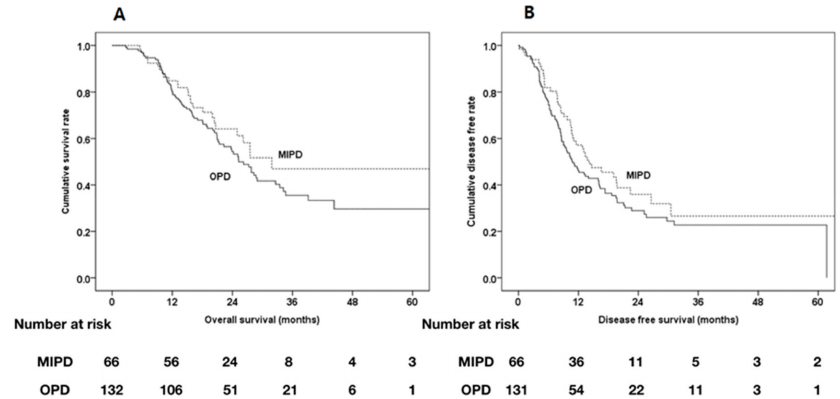
Figure 5. Kaplan-Meier survival curves of MIPD group ( n = 66) and OPD group ( n = 132) after propensity score matching with pathologic finding. ( A ) Median OS and estimated 1-, 2-, and 5-year OS were 31.9 months and 84.8%, 64.1%, and 47.0% in the MIPD group, and 25.3 months, 80.3%, 54.4%, and 29.6% in the OPD group, respectively ( p = 0.177). ( B ) Median DFS and estimated 1-, 2-, and 5-year DFS were 14.1 months and 57.1%, 36.0%, and 26.6% in the MIPD group and 10.8 months and 46.3%, 28.9%, and 22.8% in the ODP group, respectively ( p =